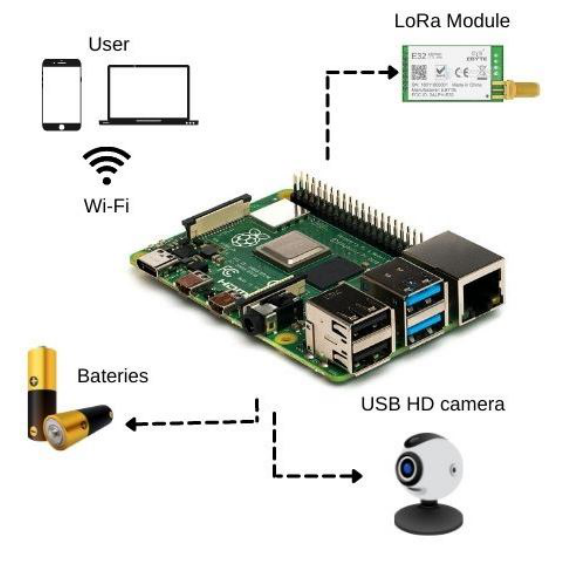
Figure 4. Collector node